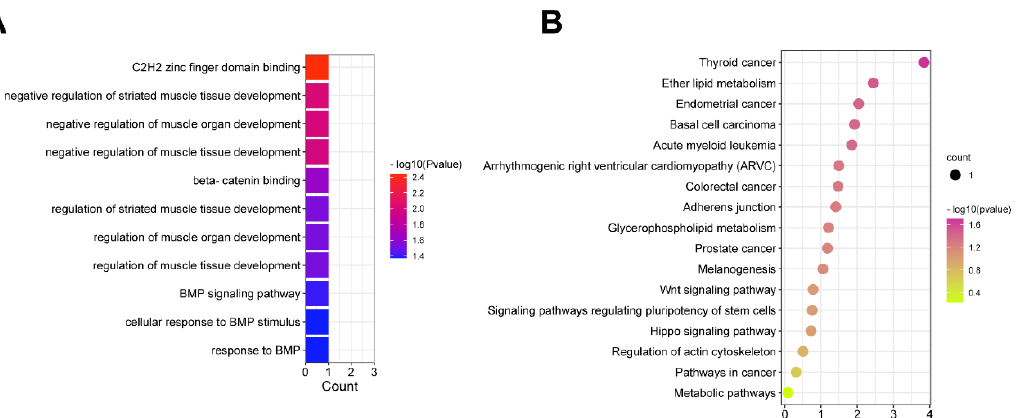
Figure 3. Functional enrichment analysis of co-expressed miRNA – mRNA network. GO ( A ) and KEGG ( B ) analysis indicated the involvement of miR-34a / Lef1 in fat deposition. KEGG ( B ) analysis indicated the involvement of miR-34a / Lef1 in fat